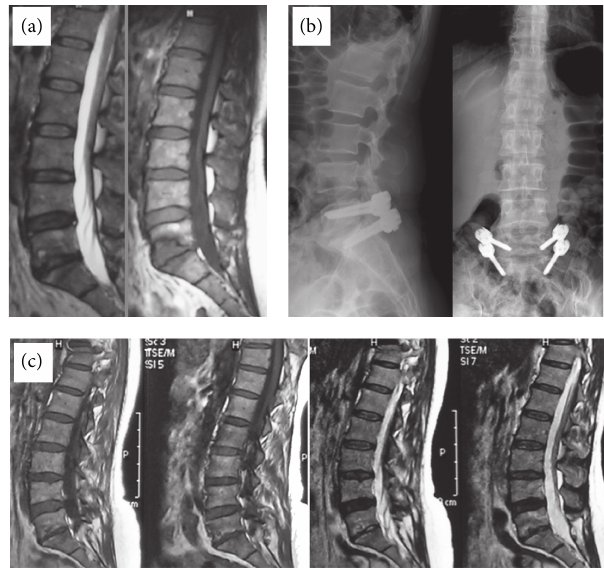
Figure 1: A 43-year-old female patient complained of severe back pain, particularly when standing or walking. (a) T1- and T2- weighted images showing hypointense corpus changes in upper and lower endplates. (b) Dynamic stabilization carried out with Safinaz screws. (c) T1- and T2-weighted MR images showing degenerative changes that shifted to Modic type 3, 2 years